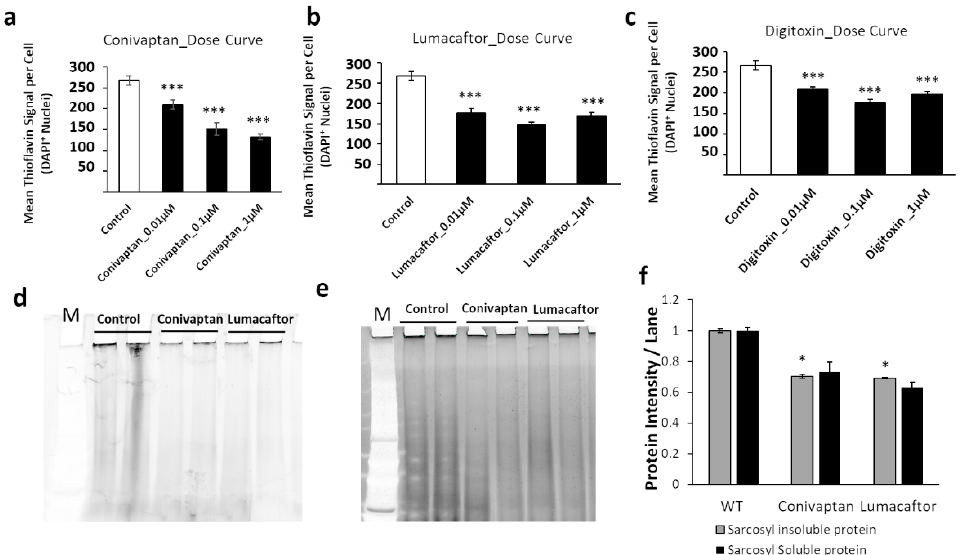
Figure 7. Drug effects in human cells. ( a – c ) Dose – response curves for SY5Y-APP Sw cells treated with three top-ranked drugs at 0.01, 0.1, or 1 µM. Cells were stained with thioflavin T and DAPI to quantify amyloid per cell. Significances according to two-tailed t-tests (100 < N <150): *** p < 10 ‒5 . Sarkosyl-insoluble ( d ) and sarkosyl-soluble aggregates ( e ) from SY5Y-APP Sw cells were resuspended in Laemmli buffer at 95 °C and electrophoresed on acrylamide gels. Gels were stained with SYPRO-Ruby and protein quantified as fluorescence per lane. ( f ) Histogram shows sarkosyl-insoluble and sarkosyl-soluble aggregate proteins from gels such as those illustrated in panels ( d ) and ( e ). Significances based on one-tailed heteroscedastic t -tests ( N = 4): * p ≈ 0.01.